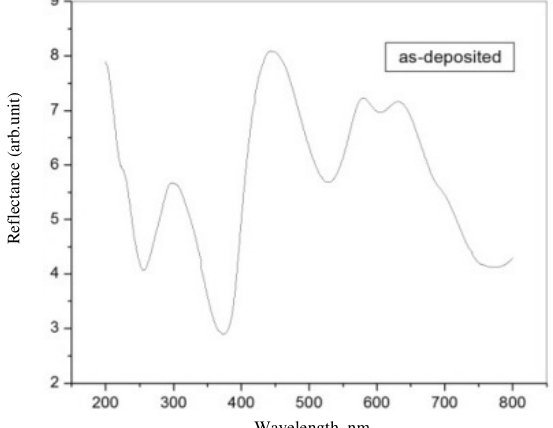
Figure 3. Reflectance versus wavelength for as-deposited F The extinction coefficient k is calculated using the